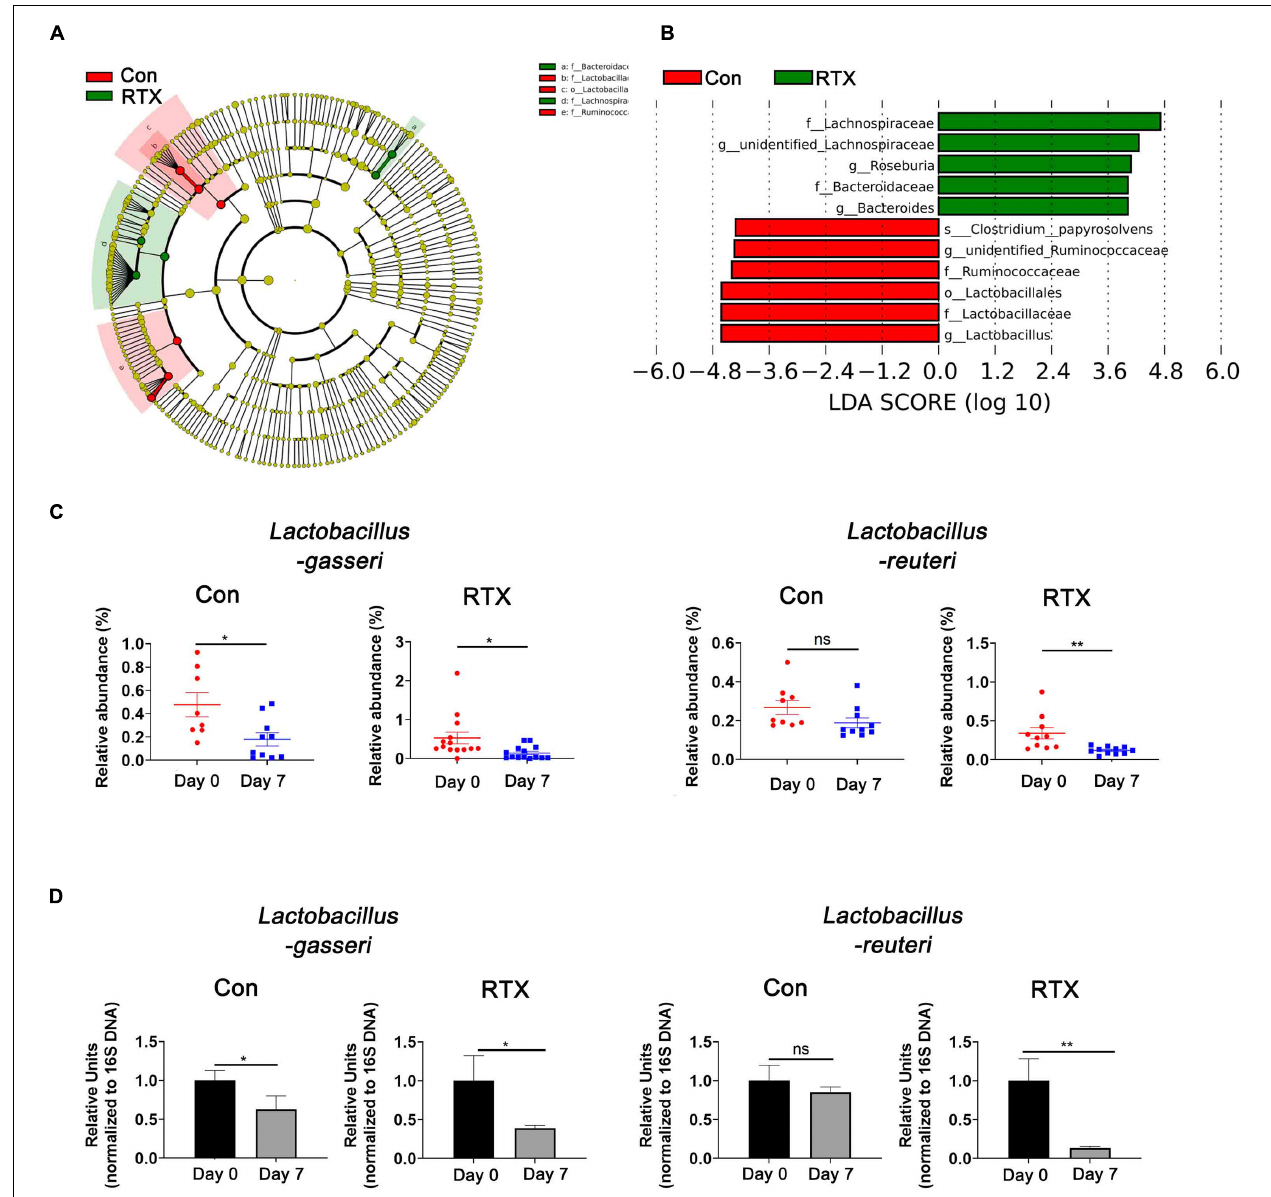
FIGURE 4 | Lactobacillus reuteri is associated with RTX-induced intestinal mucositis. (A) LEfSe analysis of differentially abundant species in RTX-treated mice on day 0 (R1) and day 7 (R2). (B) LDA scores of differentially abundant species in the intestine before and after RTX treatment showing only the groups with an LDA threshold > 3.6. (C) The relative abundance of significantly different bacteria in control and RTX treatment groups. (D) qPCR results of different bacteria in feces samples. Data are shown as the mean ± SEM. * p < 0.05, ** p <